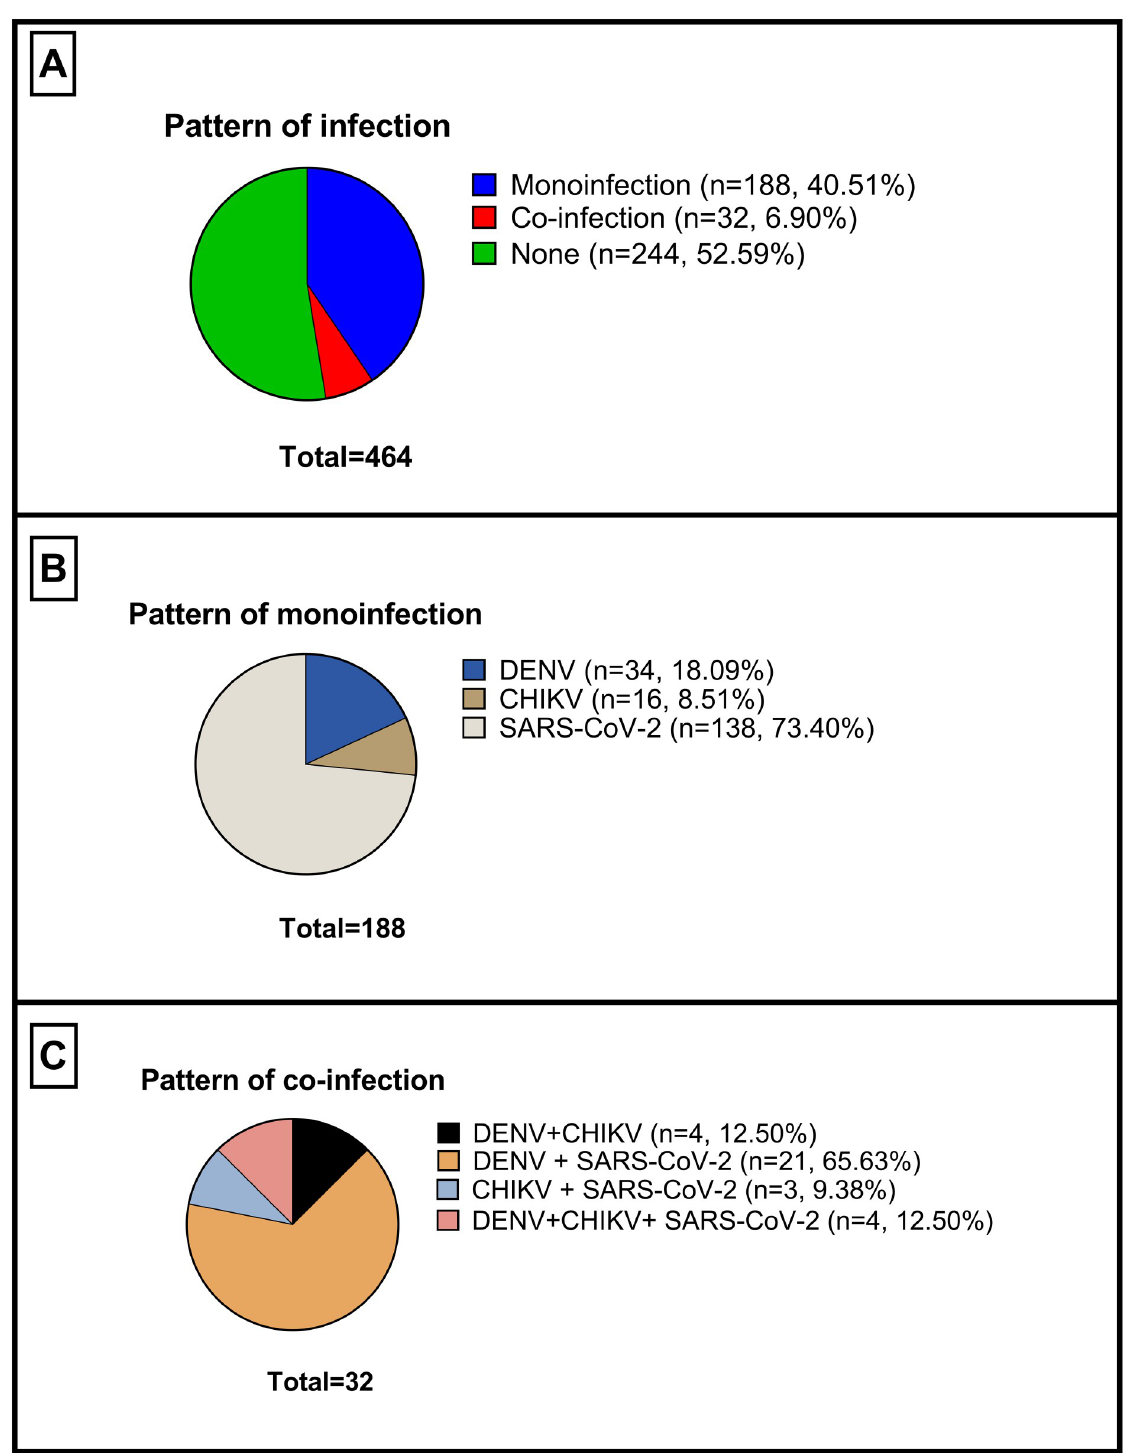
Fig 2. A. Patterns of infection B. Patterns of monoinfection C. Patterns of co-infections.